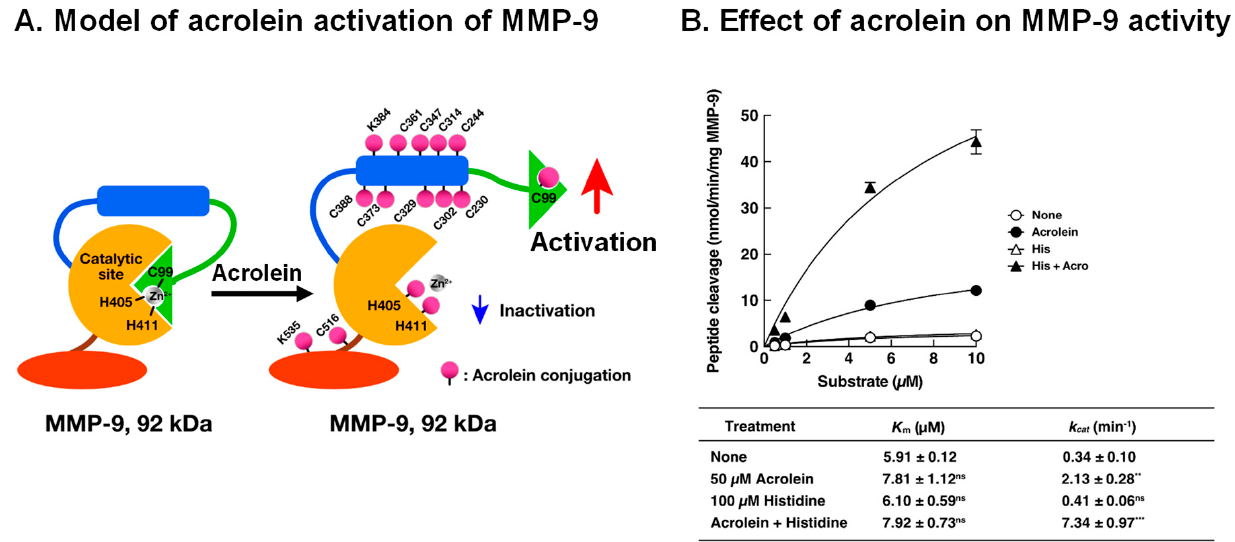
Figure 6. Activation model of MMP-9 by acrolein and effect of acrolein on enzymatic activity of MMP-9. ( A ). Activation model of MMP-9 by acrolein was created according to the cysteine switch model of MMP-7 [57]. Green, propeptide domain; blue, fibronectin repeats; orange, active site including Zn 2+ binding site; brown, glycosyl domain; red, hemopexin domain. ( B ). The K m and k cat values of acrolein-activated MMP-9 with or without histidine. MMP-9 was incubated with 50 µ M acrolein with or without 100 µ M His at 37 ◦ C for 3 h, and the MMP-9 activity was measured by changing the substrate concentration. The K m and k cat values were calculated using a Lineweaver–Burk plot. Adapted with permission from Ref. [55]. 2017 Elsevier. ** p < 0.01, *** p <